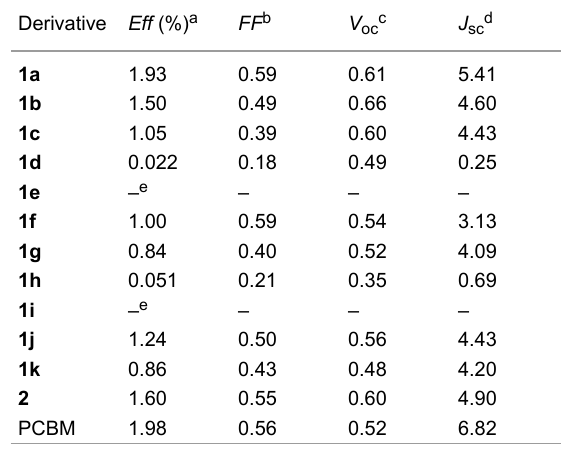
Table 2: J – V characteristic parameters of bulk–heterojunction solar cells Derivative Eff (%)